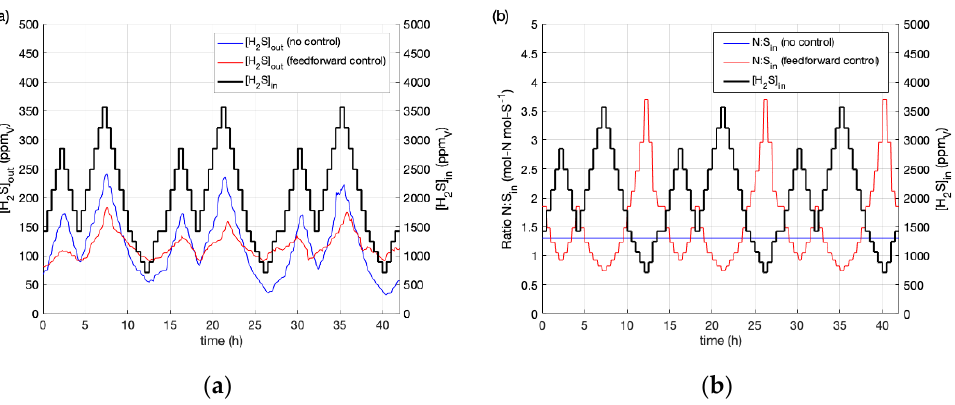
Figure 5. Profiles along experimental tests. ( a ) H 2 S out concentration. ( b ) Inlet molar ratio N:S in . Blue lines: controlled experiments; dashed black lines: H 2 S in ; red lines: experiments without control.